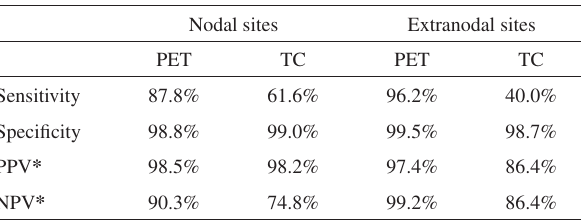
Table 4 - Assessment of the overall accuracy rates using CT and FDG-PET on nodal and extranodal